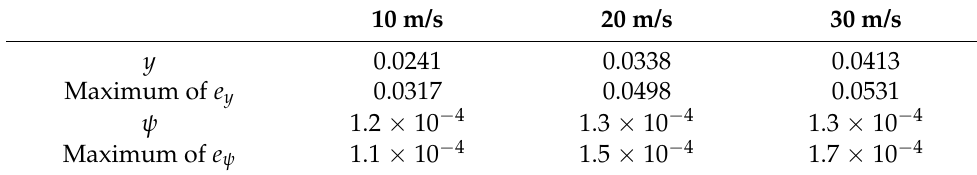
Table 3. Comparison under different velocities.